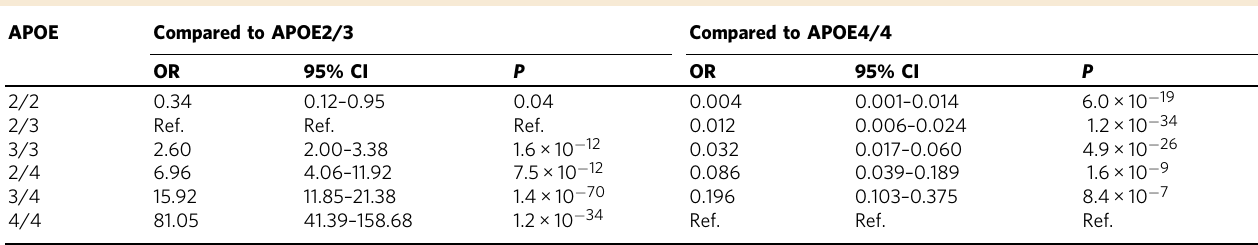
Table 2 Association of each APOE genotype in the neuropathologically con fi rmed group. APOE